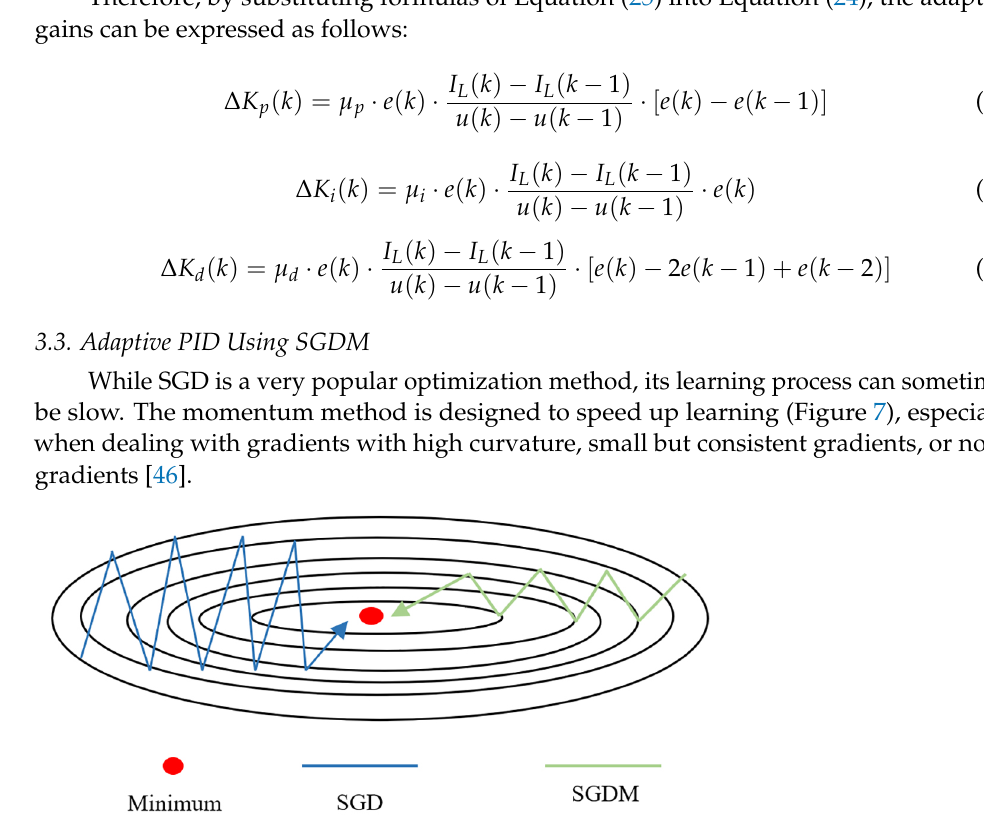
Figure 7. SGDM vs.